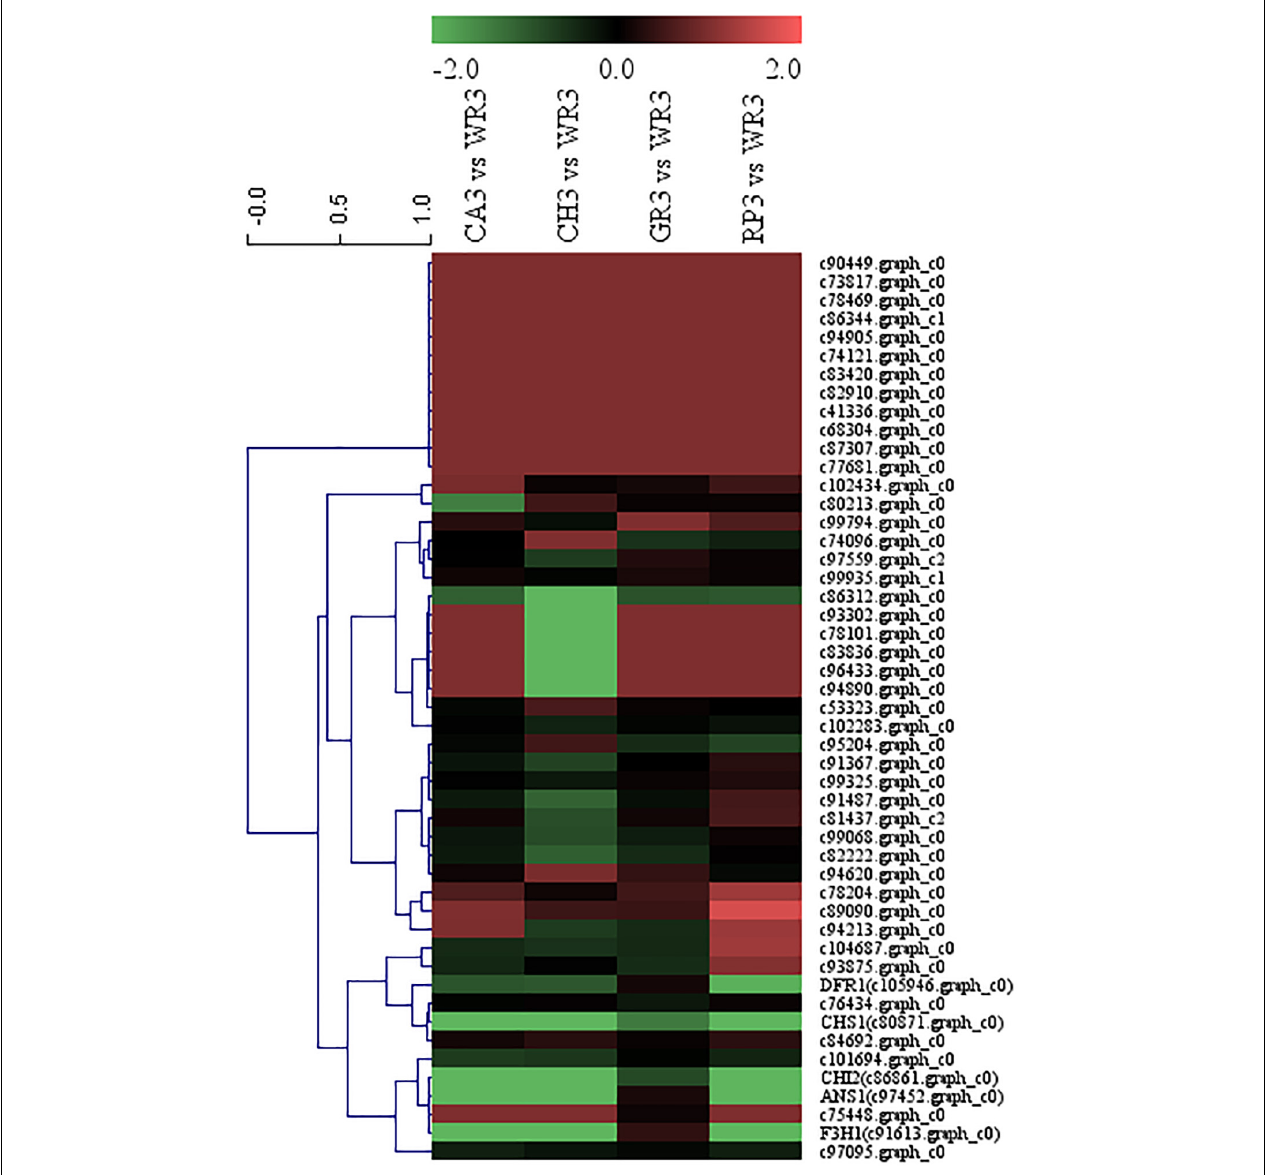
FIGURE 6 | Cluster thermogram of AP2 with key structural genes in flavonoid biosynthesis process of Freesia hybrida